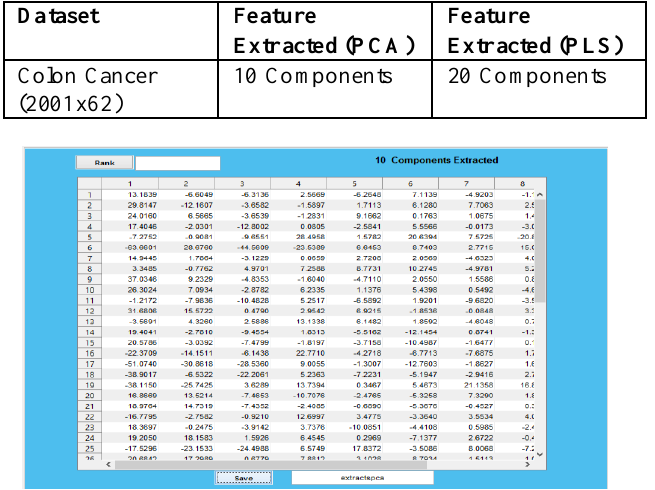
Figure 2: PCA Features Extracted 10 Components